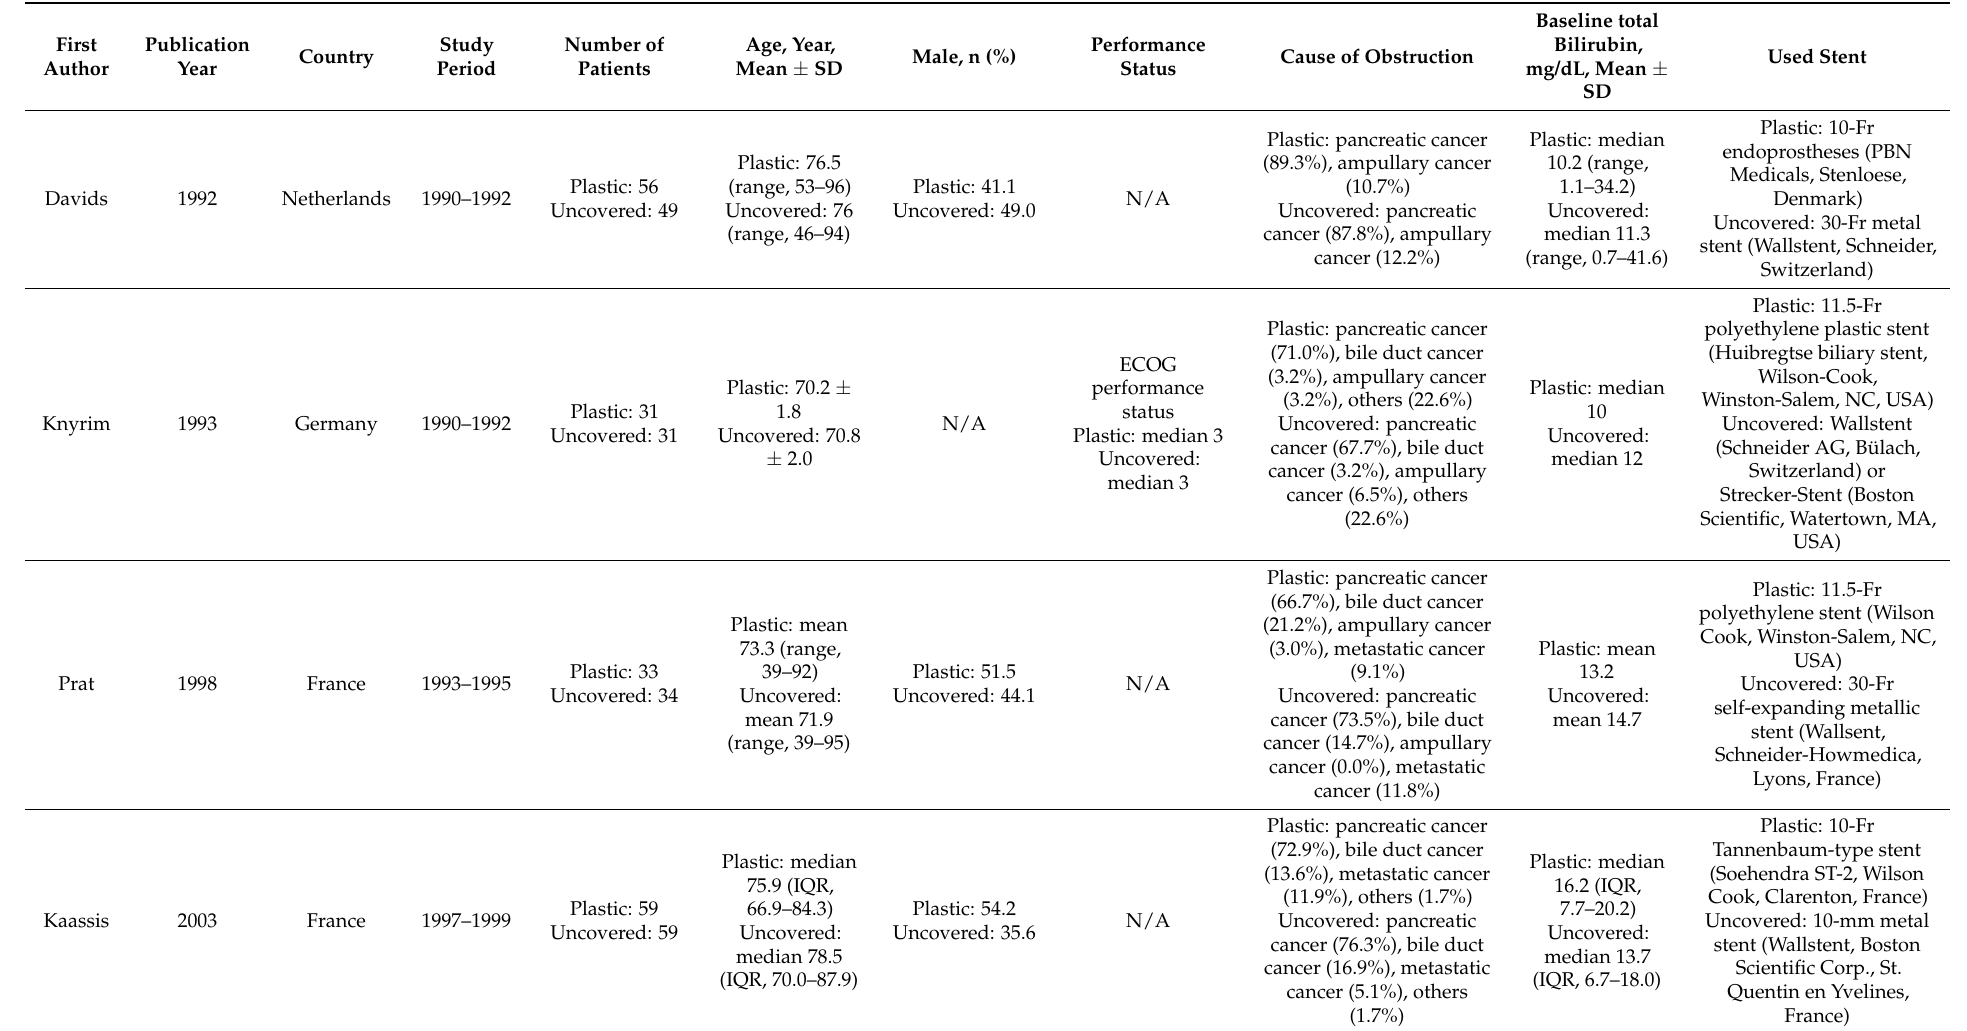
Table 1. Baseline patient and lesion characteristics in the included